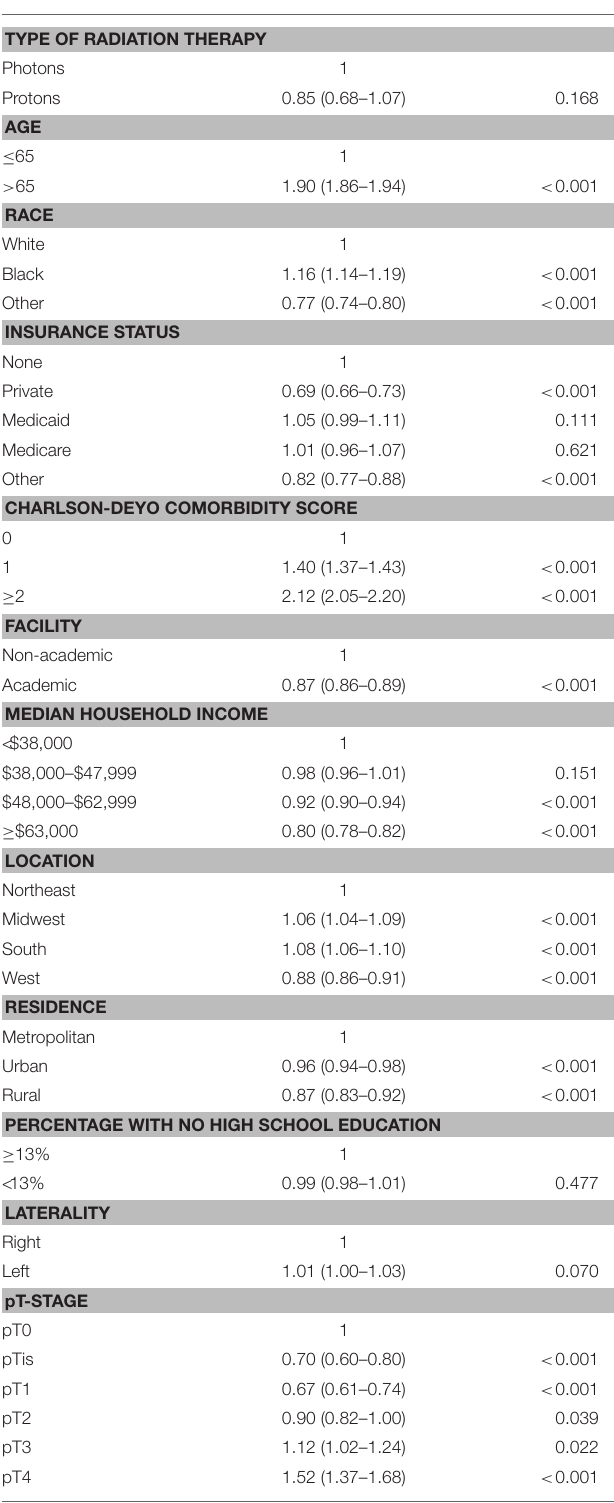
TABLE 2 | Multivariable Analysis for overall survival in non-metastatic breast cancer patients treated with adjuvant radiation therapy. Hazard ratio (95% Confidence